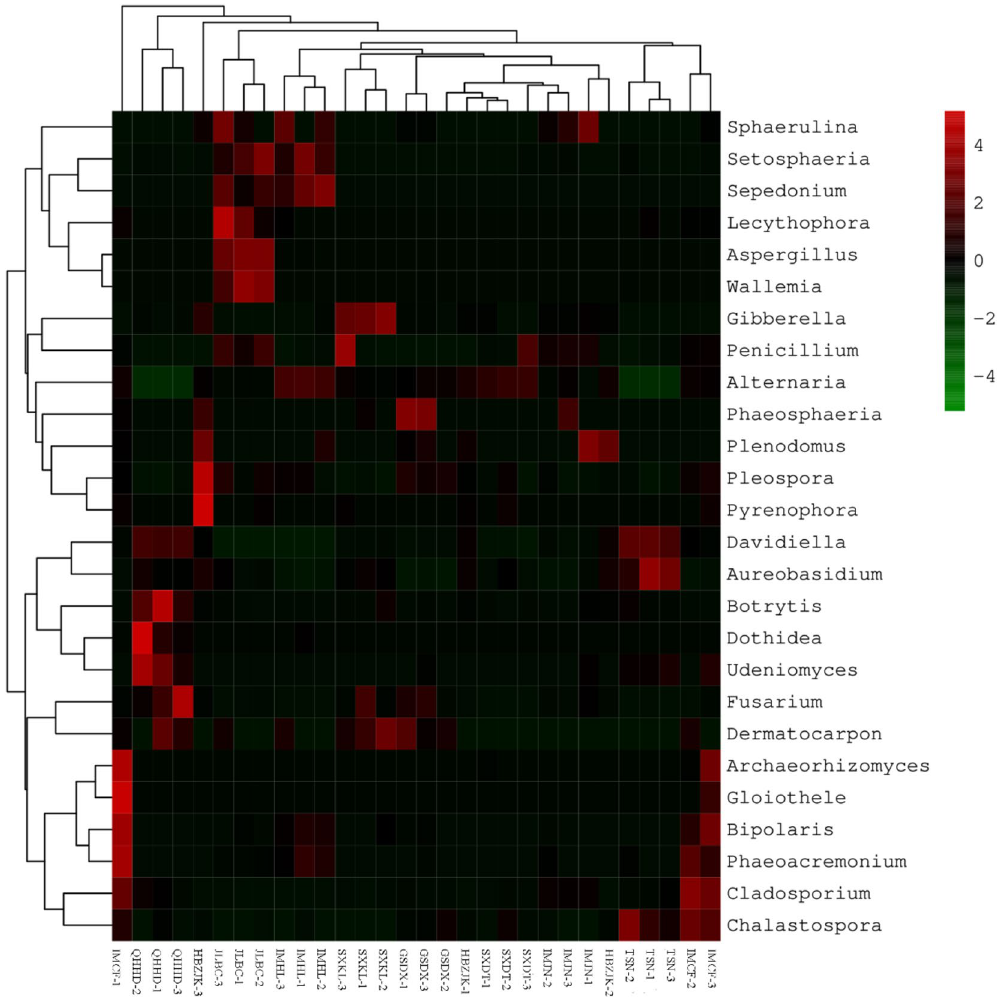
Figure 2. 16S rDNA sequencing reveals the relationship and classification of fungal pathogens on the surfaces of Bayou 13 grains from 10 ecological regions at the genus level. The weighted UniFrac UPGMA tree is based on 13 fungal genera. The heat map shows the relative abundance of the 13 genera within each sample that were most abundant in the entire dataset. The abundance data were normalized by range-scaling each class to Log 2 . SXKL, TSN, QHHD, SXDT, GSDX, IMCF, IMJN, IMHL, HBZJK and JLBC indicate Kelan County in Shanxi Province; Shannan Prefecture in Tibet; Haidong Prefecture in Qinghai Province; Datong City in